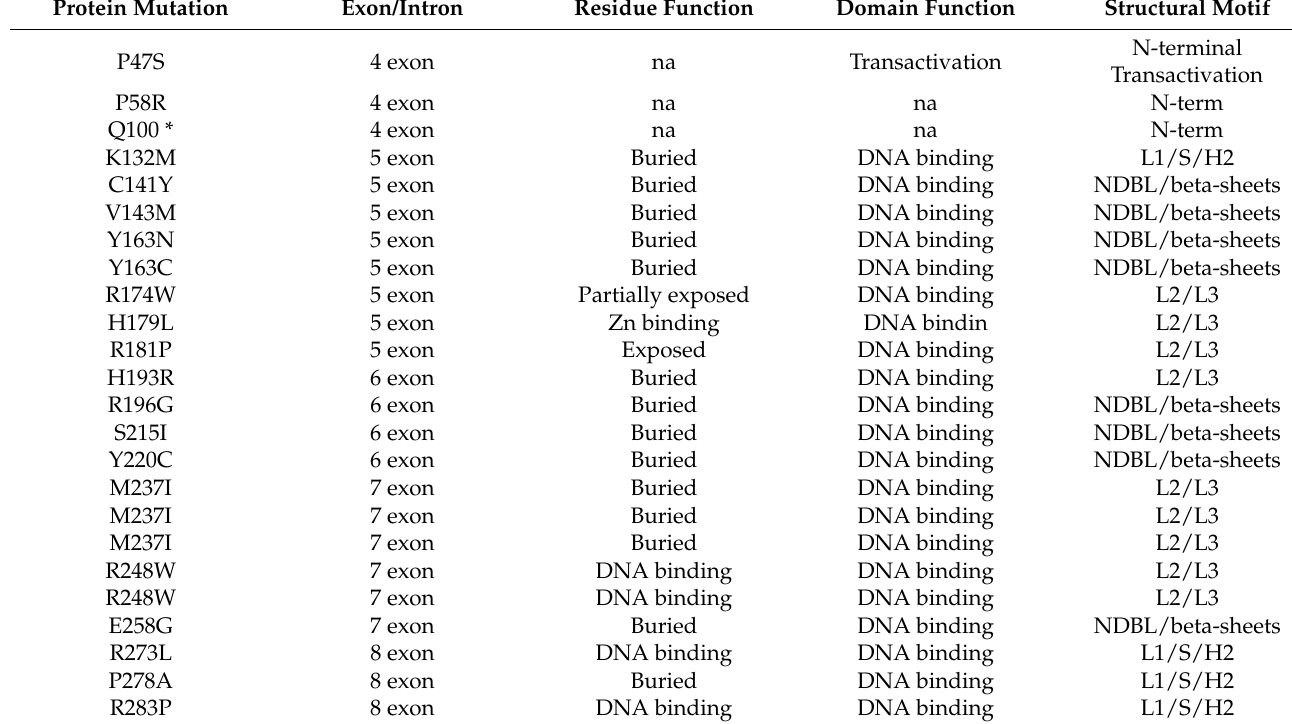
Table 3. Catalog of common and unique TP53 mutations for lung cancer.